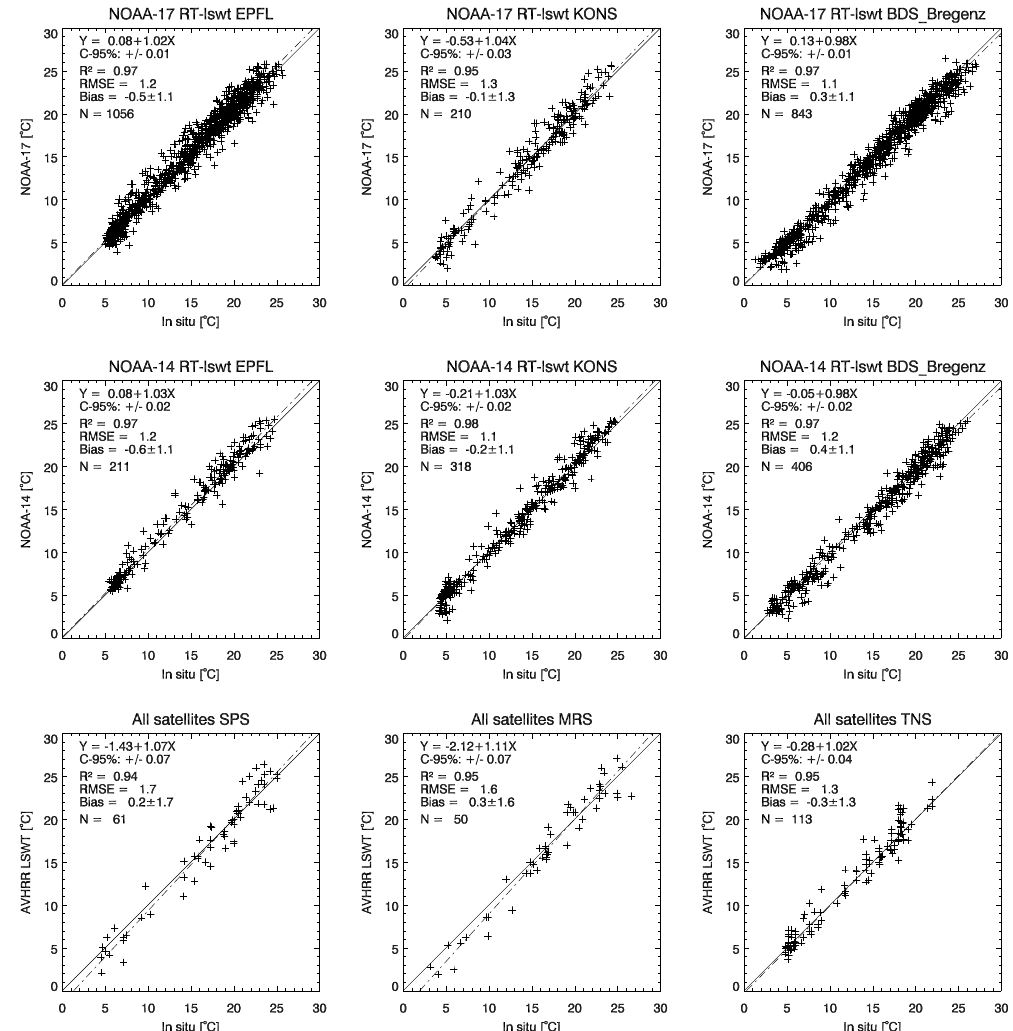
Figure 5. Scatter plots with the comparison between in situ observations and the regional LSWT-retrieval based on RTTOV-10 (RT-lswt). The upper and middle panel show the comparison between individual satellites and in situ measurement, whereas in the lower panel all satellites together are shown, since for these lakes only few in situ measurements were available. Shown are the linear regression equation (dash-dotted); the 95% confidence interval of the regression line; the coefficient of determination as square of the correlation coefficient ( R 2 ); the root-mean-square error (RMSE); the bias as the mean temperature difference and standard deviation ( (cid:49)T ± σ (cid:49)T ) between OBS and RT-lswt; and the number of coincident observations. In situ locations are indicated in the graph titles and are explained in Table